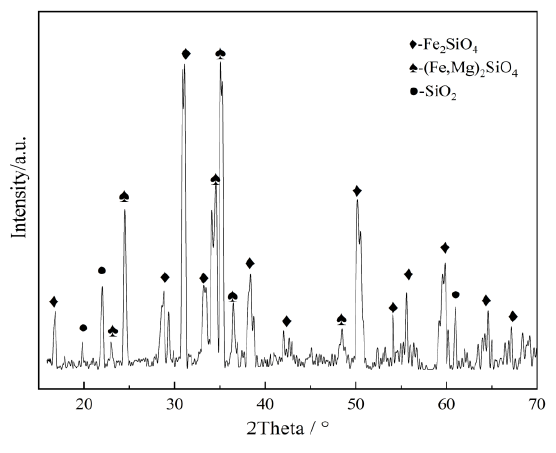
Figure 1. X-ray diffraction patterns of nickel slag sample. Figure 1. X-ray di ff raction patterns of nickel slag